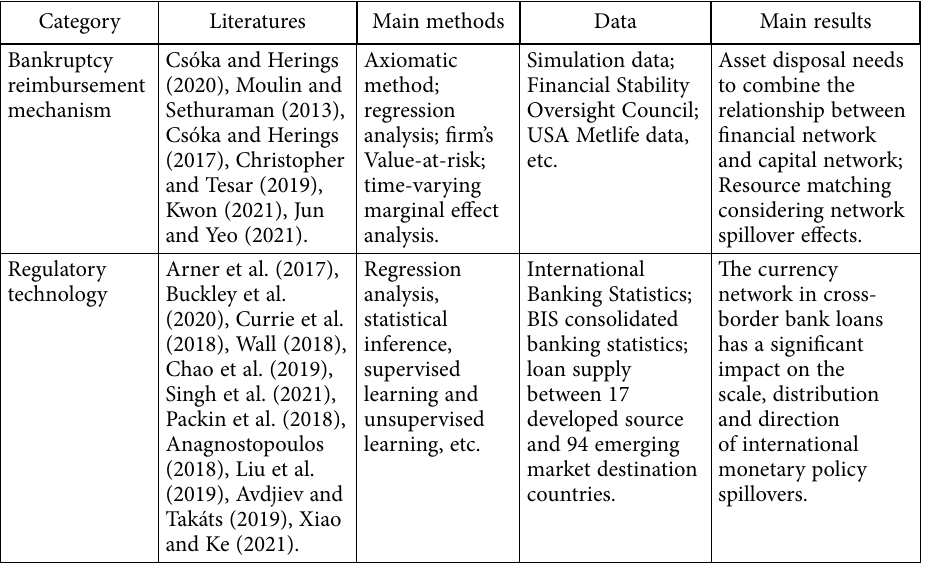
Table 3. Representative resilience governance